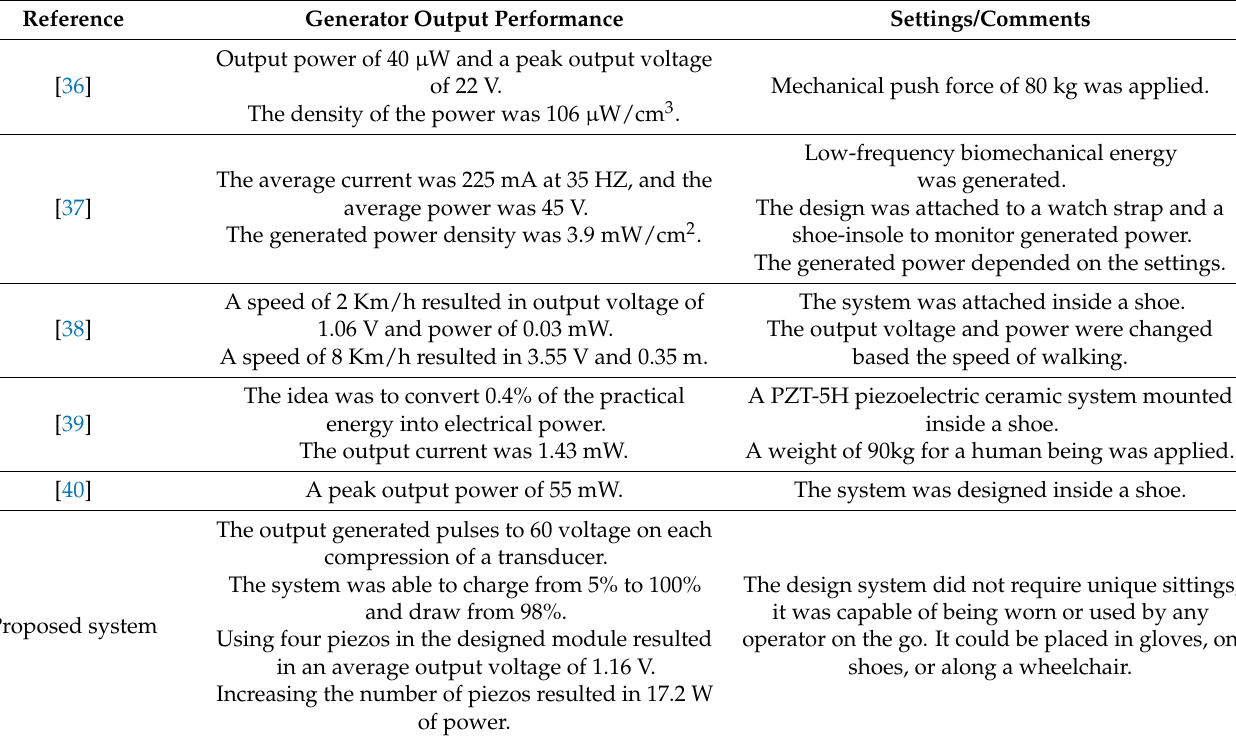
Table 1. The Output Presentation of Various Piezoelectric